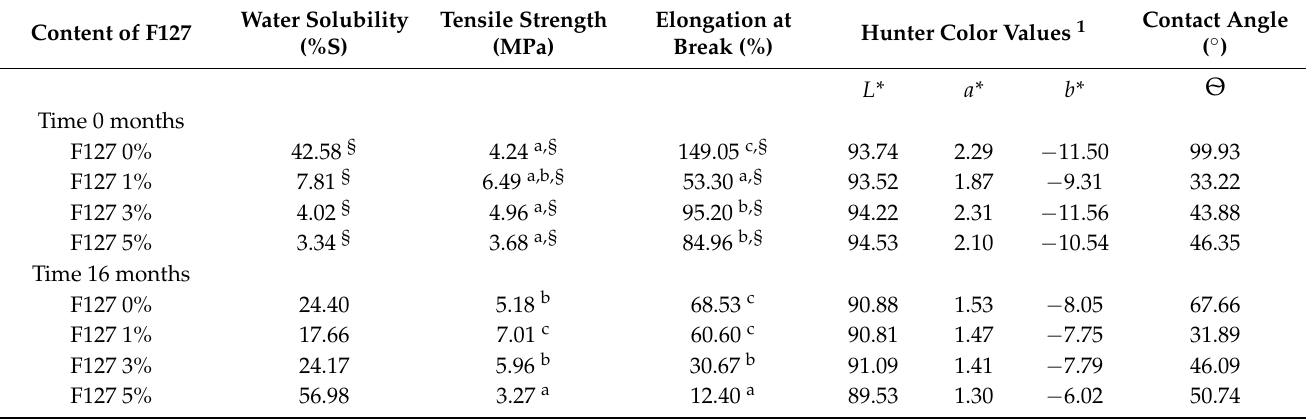
Mean values of at least three replicates. § Experimental data and significant difference taken from Fonseca-García, Jiménez- Regalado [11]. 1 Hunter color parameters, L* : color coordinate, lightness (0 = black, 100 = white); a* : color coordinate, greenness and redness (+ = red, − = green); b* : color coordinate, blueness to yellowness (+ = yellow, − = blue). L* standard= 91.76, a* standard = 2.14, and b* standard = − 10.64. a,b,c : values with different letter in a same column denote significant difference.